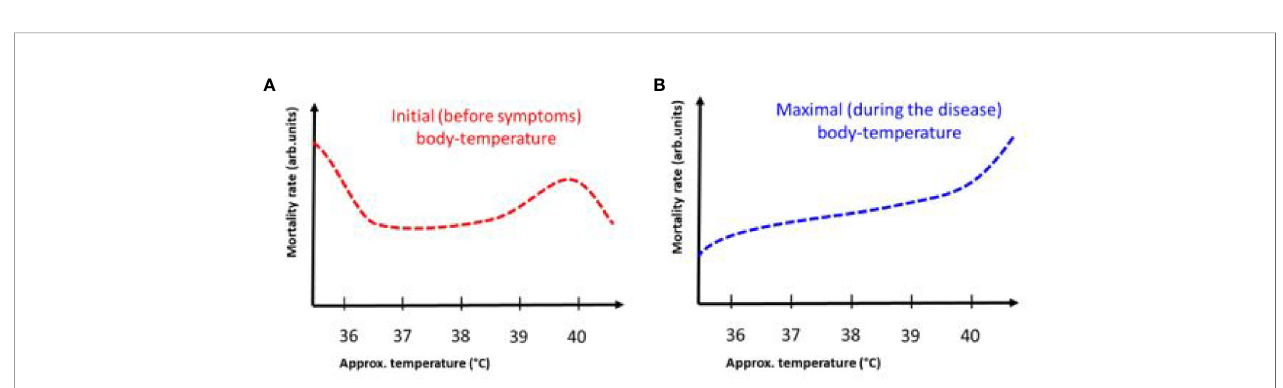
FIGURE 5 | The dependence of mortality on body temperature before and during COVID-19 infection. The trend between the two measures is different. (A) Mortality rate as a function of maximum body temperature at the onset of symptoms. The 40ºC bulge is probably due to an independent in fl ammatory effect, increasing mortality at the end of the day. (B) The mortality rate versus the maximum body temperature during the disease has a permanent increase.